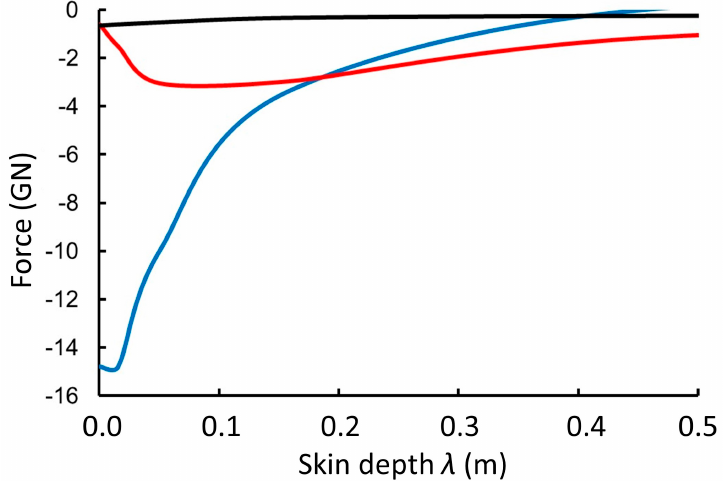
Figure 6. Components of the time-averaged force between the simulated quark nugget and conducting slab as a function of the electromagnetic skin depth λ . The negative (<0) force F z (blue) opposes gravity and levitates the rotating magnetized sphere for λ < 0.5 m, with the most negative value for λ < 0.03 m. The force generated by the magnetic field traveling through the deformable conductor in the x -direction, as the magnetized sphere rotates about the y -axis, generates a propulsive force F x (red). F x is much less than F z for small skin depths. The much smaller F y (black) illustrates ±5% error in the calculation, since symmetry requires F y = 0.